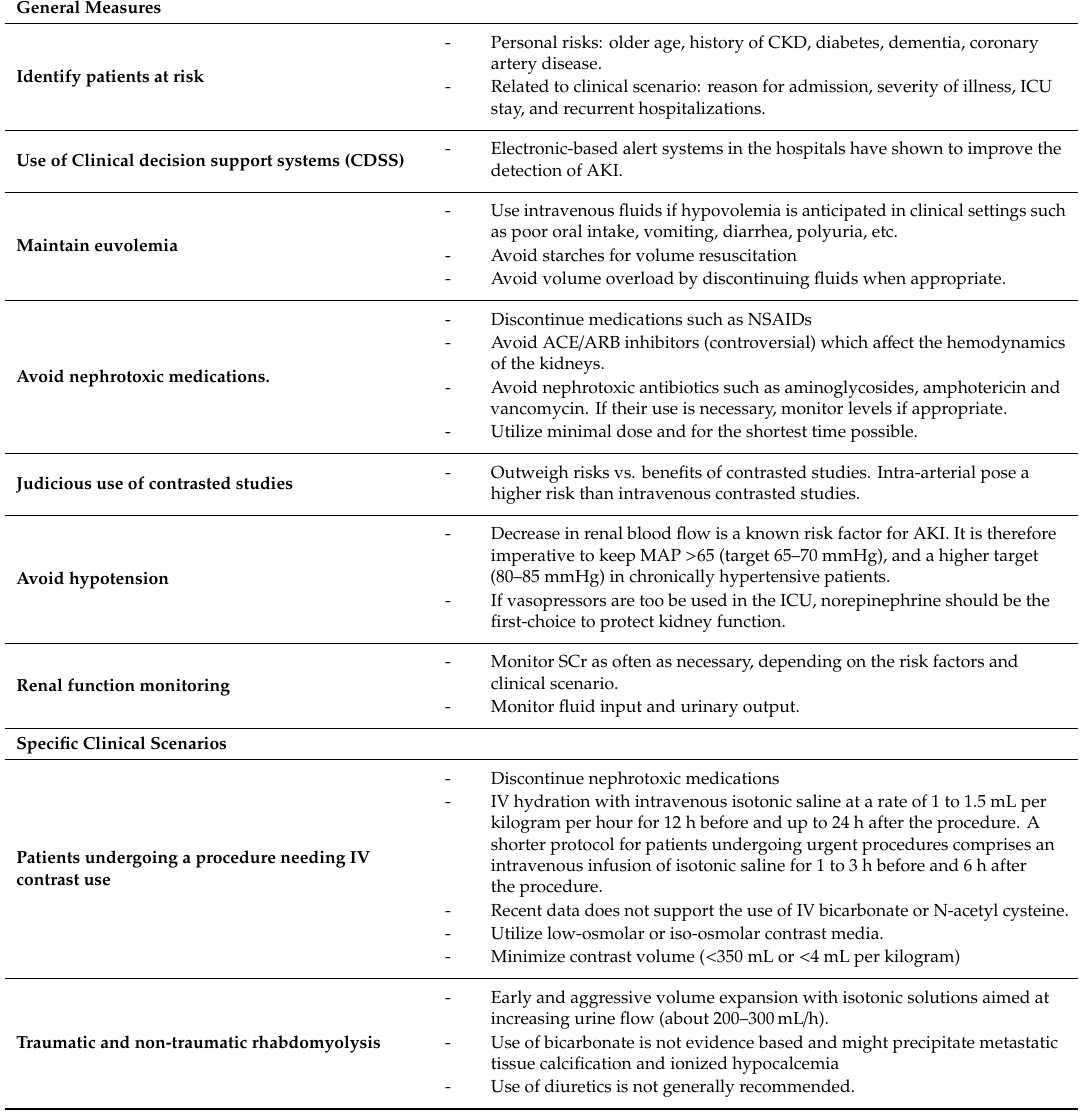
Table 7. AKI prevention